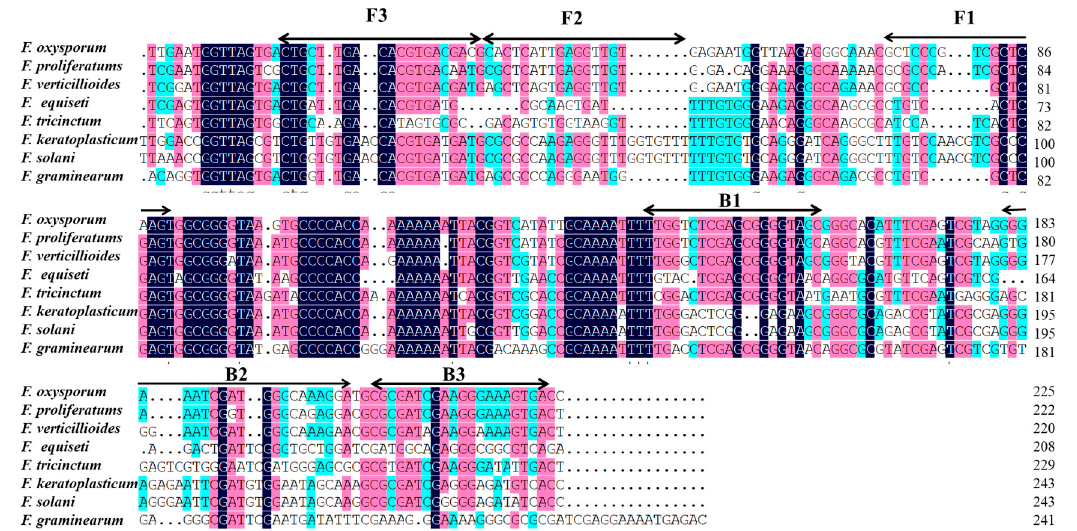
Figure 2. The nucleotide sequence alignment of the translation elongation factor-1 α ( TEF-1 α ) genes were used to design the LAMP primers.